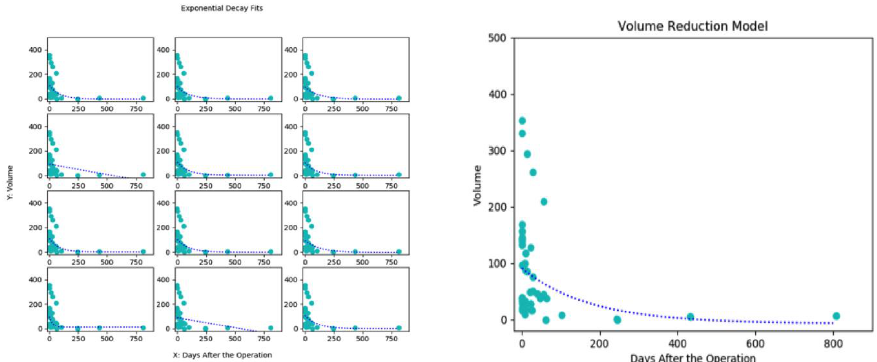
Figure 1. All twelve coniglobus models were first plotted ( left ). After cross-validation, the best fit based on the sum of the residual squares was synthesized depict volume decay ( right ). The pathophysiology of the initial volume depends on patient characteristics, as has been described in natural history studies on subdural hematoma. Therefore, patients with larger volumes had a lower chance of complete resolution as shown by our composite average numbers. A case illustration of post-embolization recovery is shown in Figure 2.